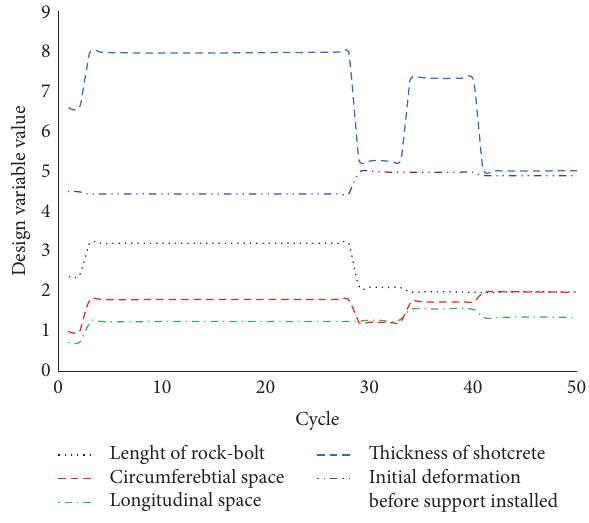
Figure 12: Variation process of the design